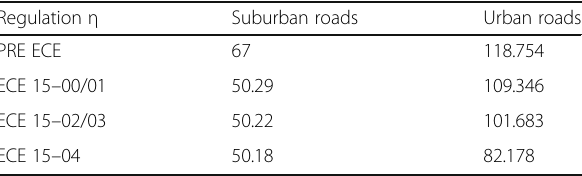
Table 4 Corinair ’ s model for fuel consumption of cars on urban and suburban roads